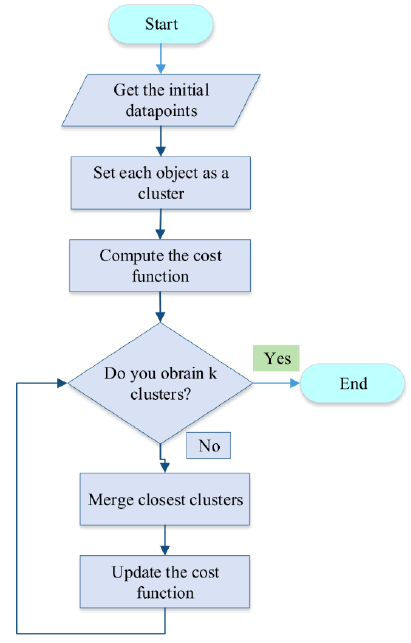
Figure 10. Linkage–Ward clustering step-by-step algorithm [15].